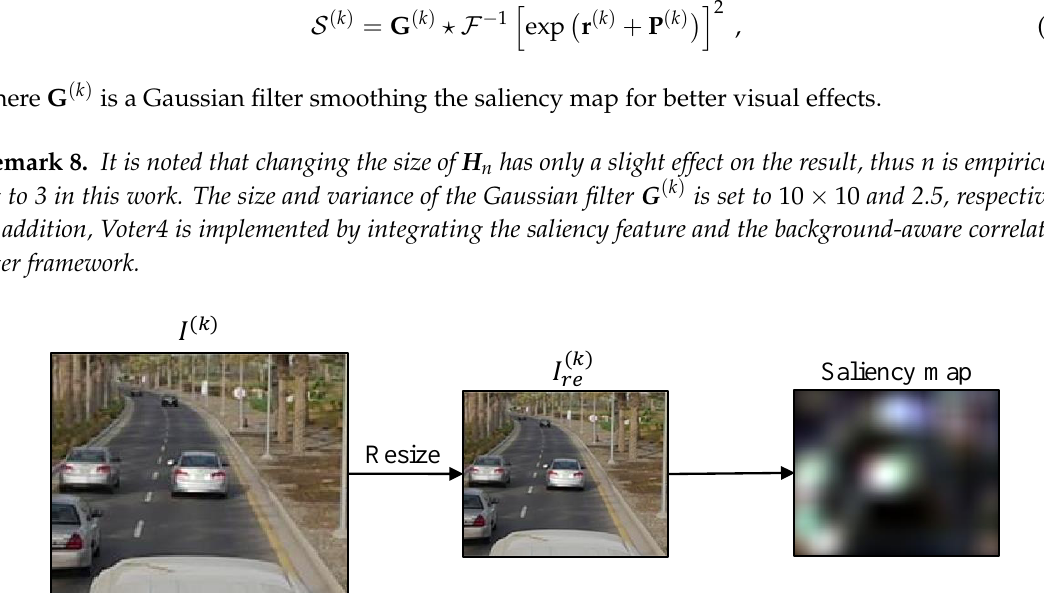
Figure 6. An example of achieving saliency